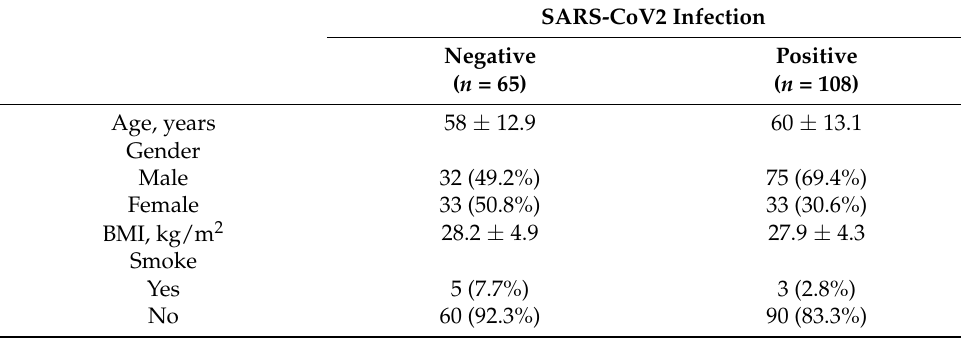
Table 1. Patients’ general characteristics, and clinical parameters at